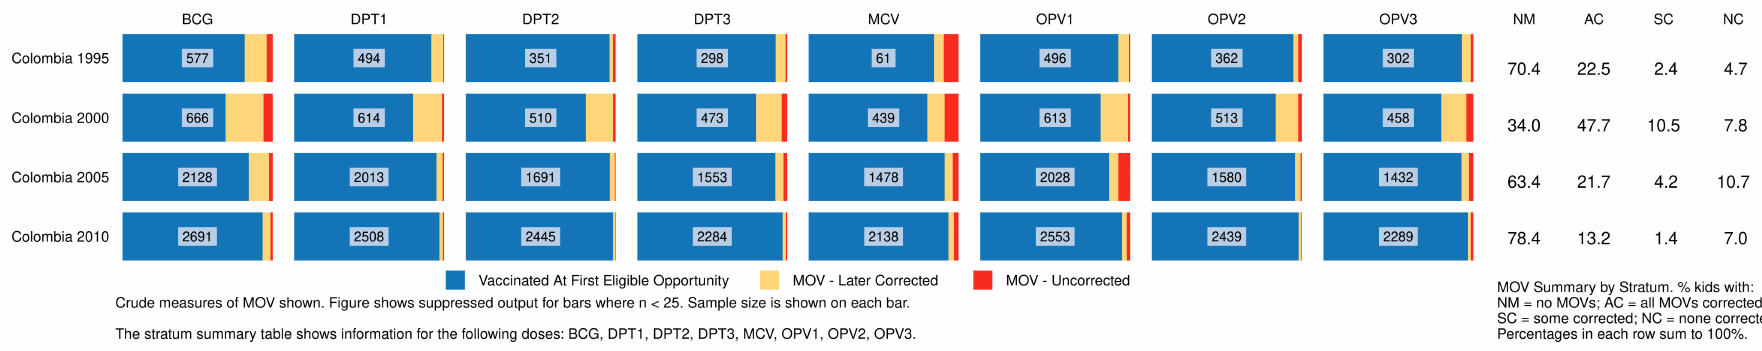
Figure 4. Proportion of children who experienced MOSVs & correction status at the time of survey, by dose, Colombia 1995–2010. Detailed counts of children represented in each Figure 4 bar portion are documented in supplementary Table